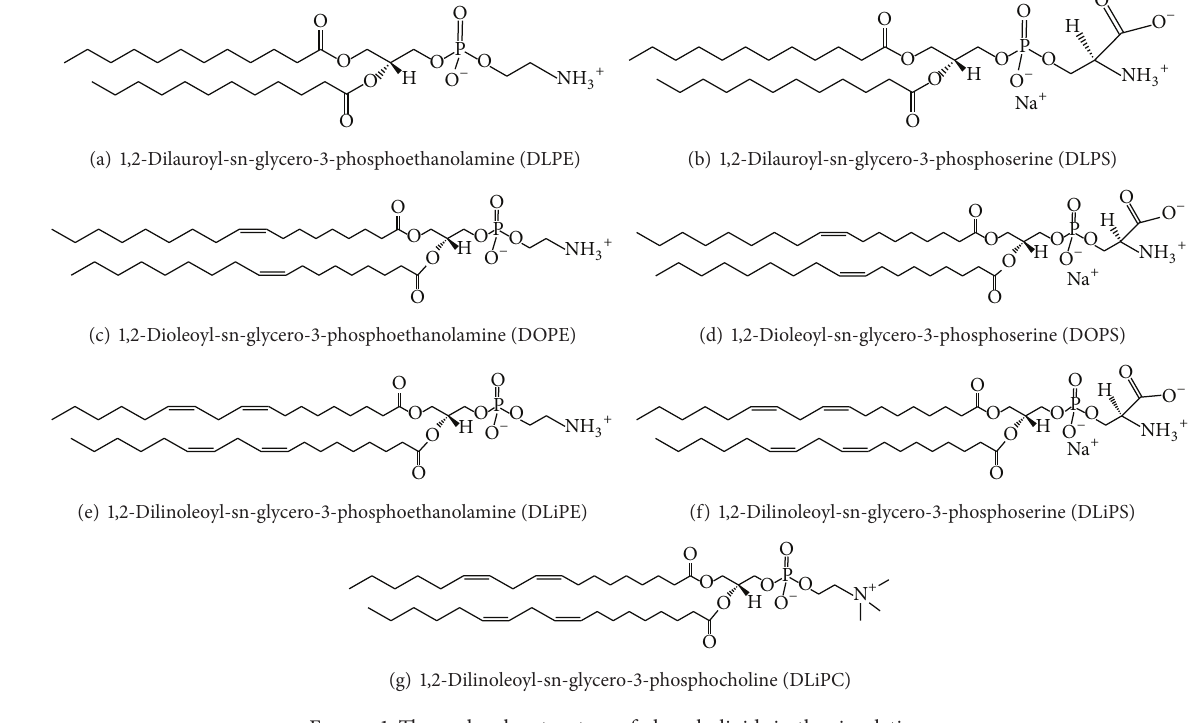
Figure 1: The molecular structure of phospholipids in the